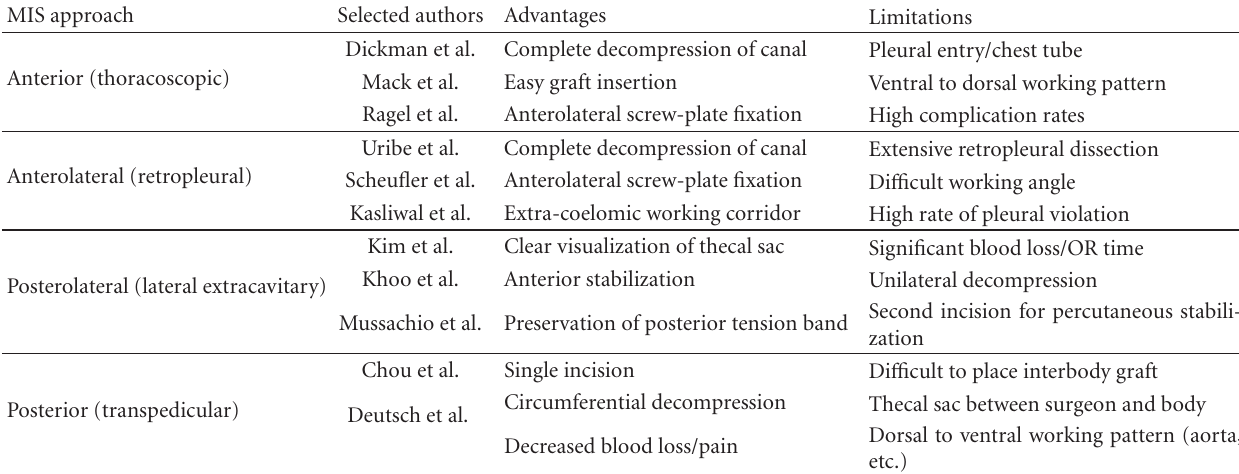
Table 1: Advantages and limitations of various minimally invasive